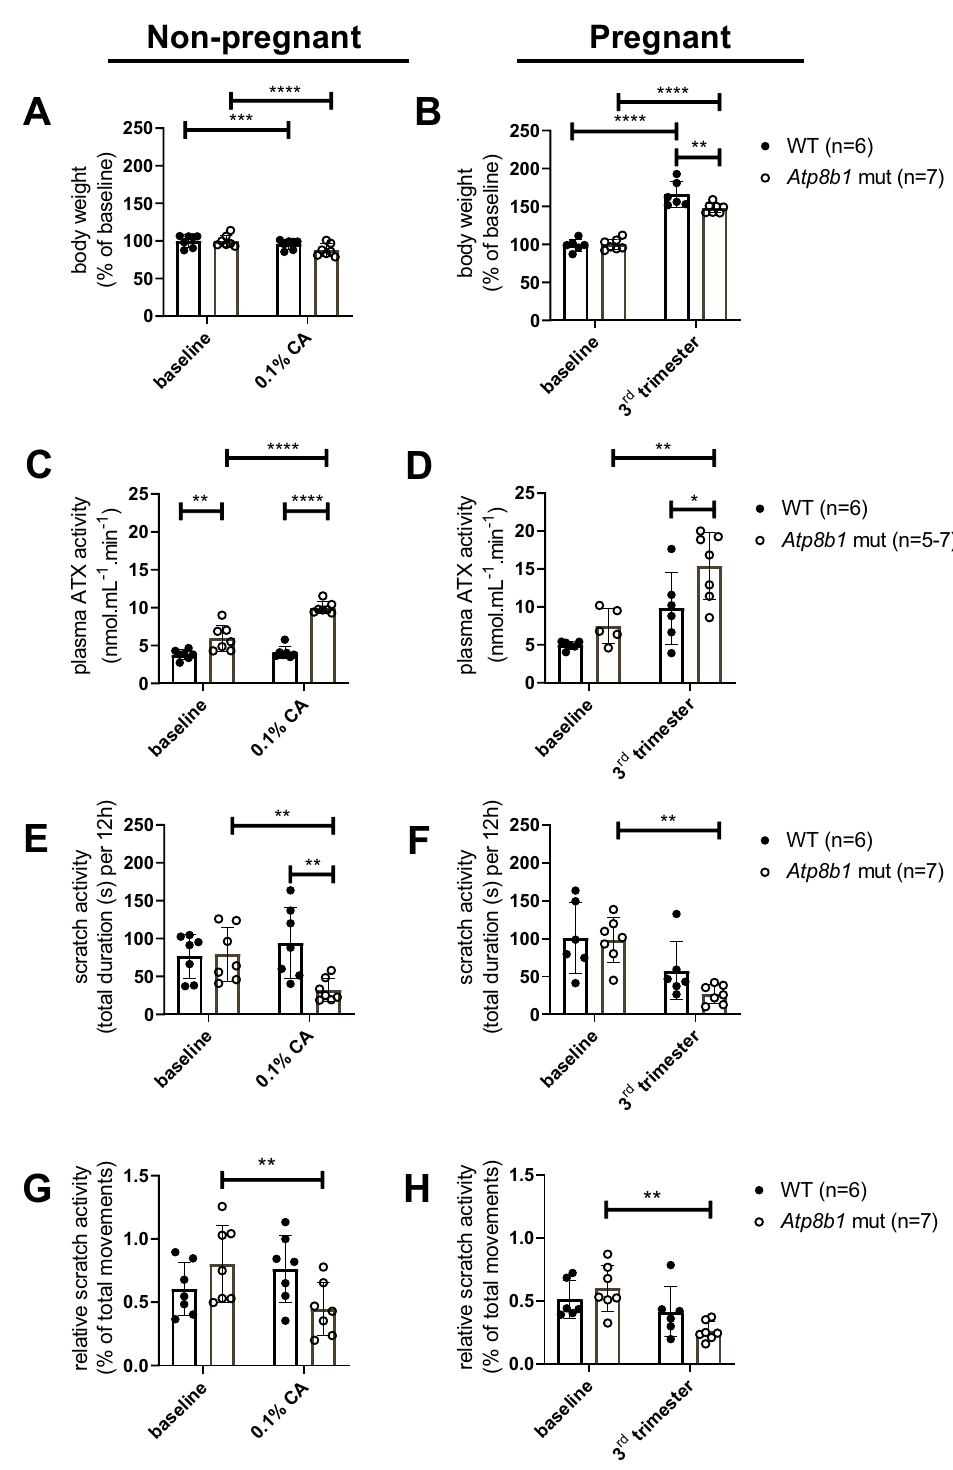
Figure 1. Body weight, plasma ATX activity and scratch activity in mouse models of cholestasis and cholestatic pregnancy. ( A,C,E,G ) Wild type mice (n = 7 females) and Atp8b1 mutant mice (n = 7 females) fed with semi-synthetic reference diet for four days and subsequently with a 0.1% CA supplemented diet for 14 days. ( B,D,F,H ) Wild type mice (n = 6 females) on a semi- synthetic reference diet and Atp8b1 mutant mice (n = 7 females) on a semi-synthetic reference diet with supplementation of 0.1% CA from day 12 of pregnancy, were observed before and during pregnancy. Body weight ( A,B ), plasma ATX activity ( C,D ) and mean scratch activity during 4 consecutive nights ( E,F ) were measured. To correct for a reduction in total movements during cholestasis and pregnancy, scratch activity is also displayed as a percentage of total time that the animals were moving ( G,H ). For total movements see Suppl. Figure 1. Plasma ATX activity data during pregnancy ( D ) is adjusted from 24 . Bars depict mean ± SD. Statistics: two-way ANOVA followed by Sidak’s post hoc test; within genotype all is shown, between genotypes only shown when significant; ns: not significant, * p -value < 0.05, ** p -value < 0.01, *** p -value < 0.001, **** p -value <